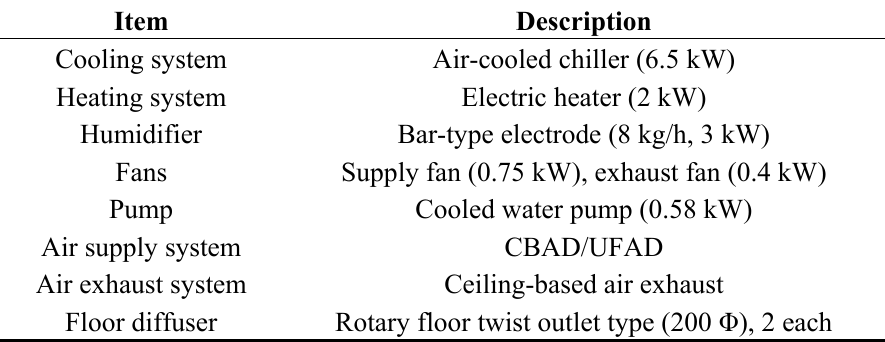
Figure 10. Diagram of chamber’s HVAC system. Table 2. Information on the air handling